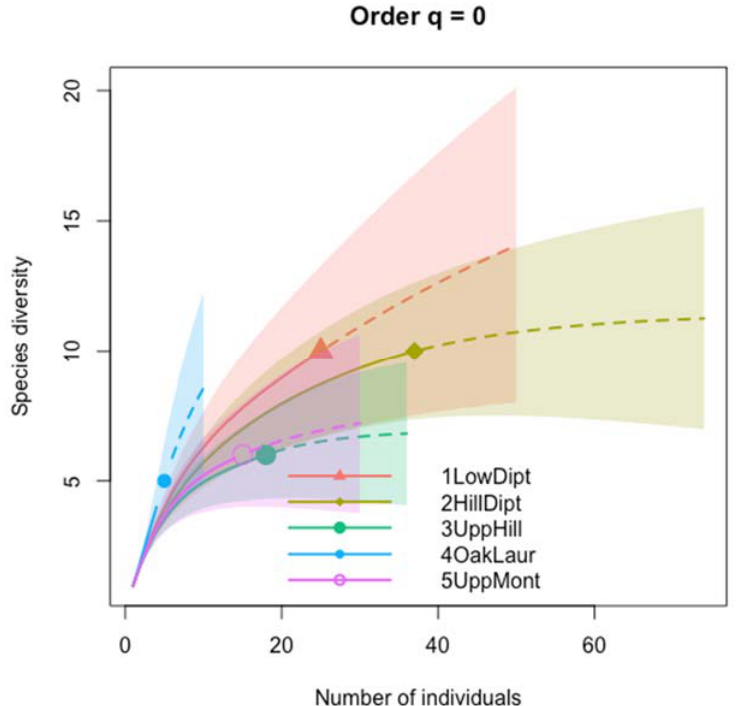
Figure 2. Species richness of fireflies estimated by iNEXT via extrapolation and rarefaction of Hill